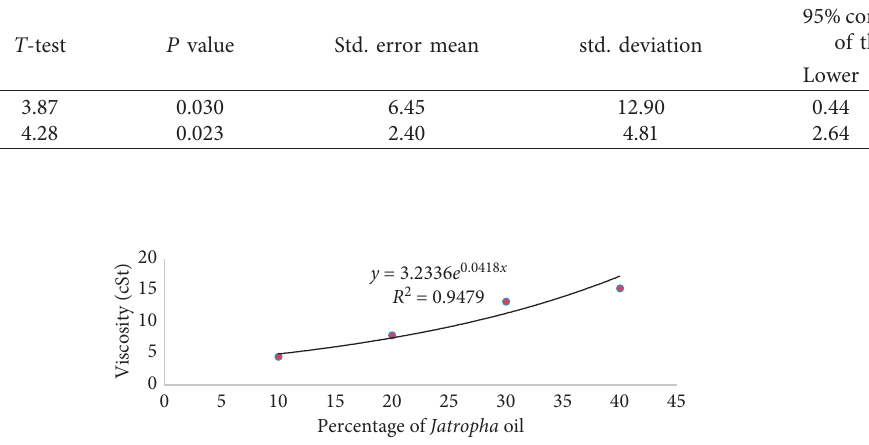
Figure 4: Effect of blending of kerosene on the viscosity of Jatropha oil.